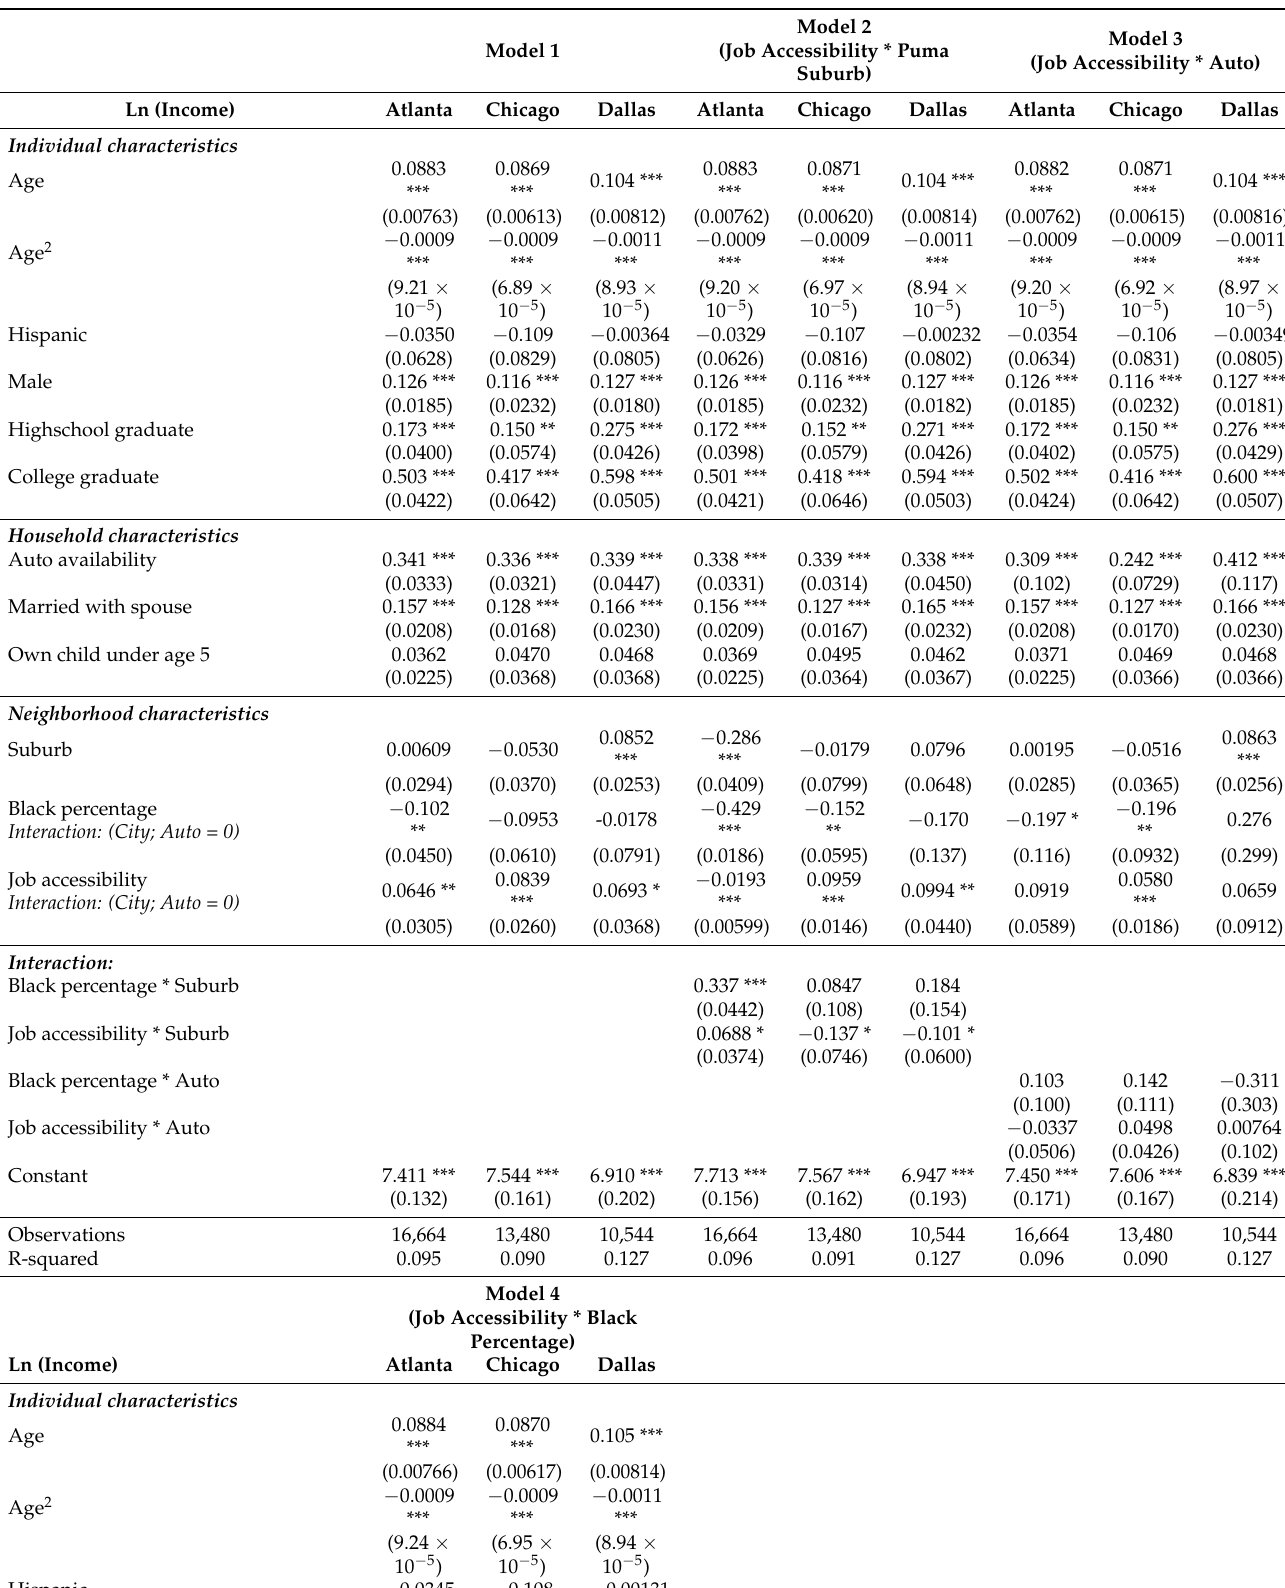
Table 3. Linear model results of log